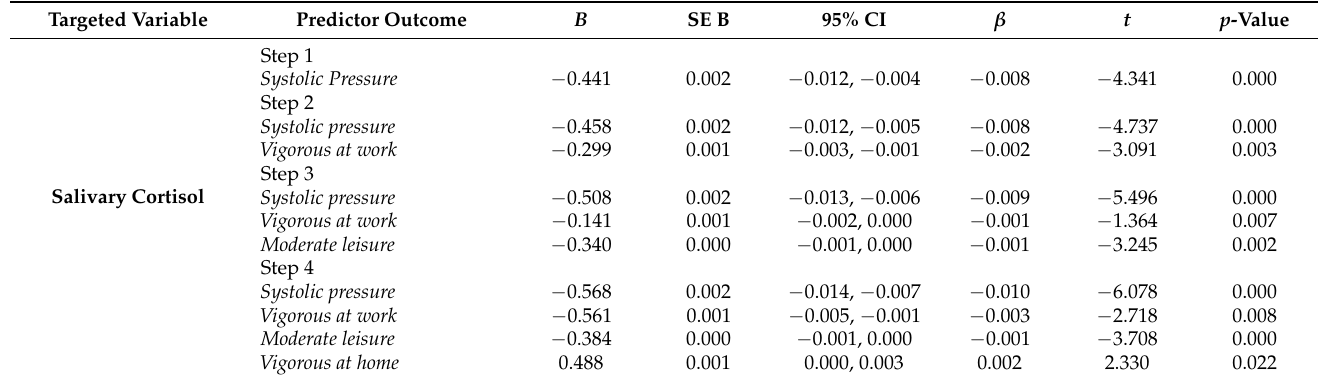
Table 6. Summary of the Regression Analyses to determine salivary cortisol